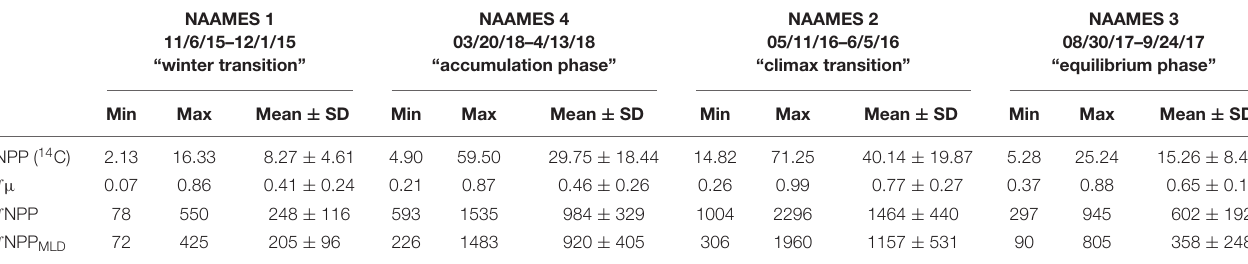
FIGURE 8 | (A) Depth-integrated net primary production ( ∫ NPP) between the surface and depth of the euphotic layer for the subarctic (red) and subtropical (blue) regions. (B) Mean concentration of optically-derived phytoplankton carbon in the mixed layer (C) The depth-integrated phytoplankton division rate ( ∫ µ ) estimated using modeled values of ∫ NPP and ∫ C. Each point represents a daily estimate of data collected while on station. Boxes represent the median, first and third quartiles, whiskers are 1.5 interquartile range. TABLE 3 | Mean and standard deviation, maximum and minimum values of net primary production (NPP) and phytoplankton division rate ( µ ) measured during the four NAAMES field